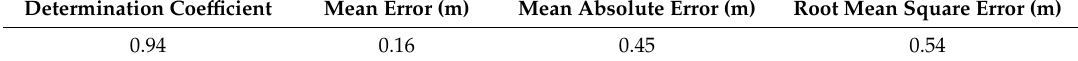
Figure A1. Simulated hydraulic head vs. Measured hydraulic head. Table A1. Model calibration statistics.